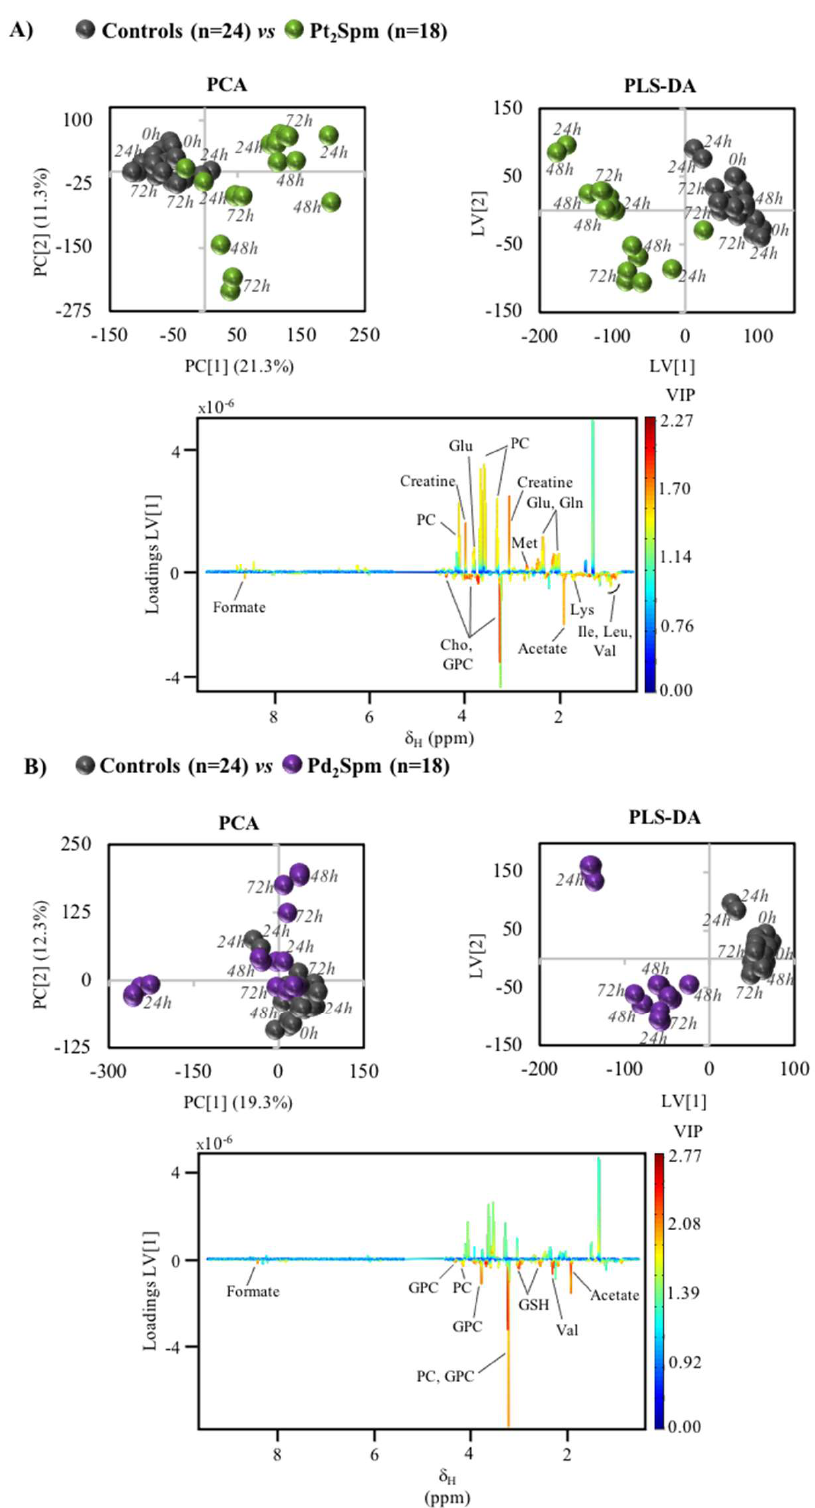
Figure 5. Multivariate analysis of MG-63 cells exposed to complexes Pt 2 Spm and Pd 2 Spm. ( A ) PCA (left) and PLS-DA (right, with LV = 2, R 2 x = 0.290, R 2 y = 0.935, Q 2 cum = 0.857) scores plots obtained for cells exposed to 240 µ M Pt 2 Spm, along LV1 loadings plot (bottom); ( B ) PCA (left) and PLS-DA (right, LV = 2, R 2 x = 0.295, R 2 y = 0.968, Q 2 cum = 0.924) scores plots obtained for 24 µ M Pd 2 Spm, along with corresponding LV1 loadings plot